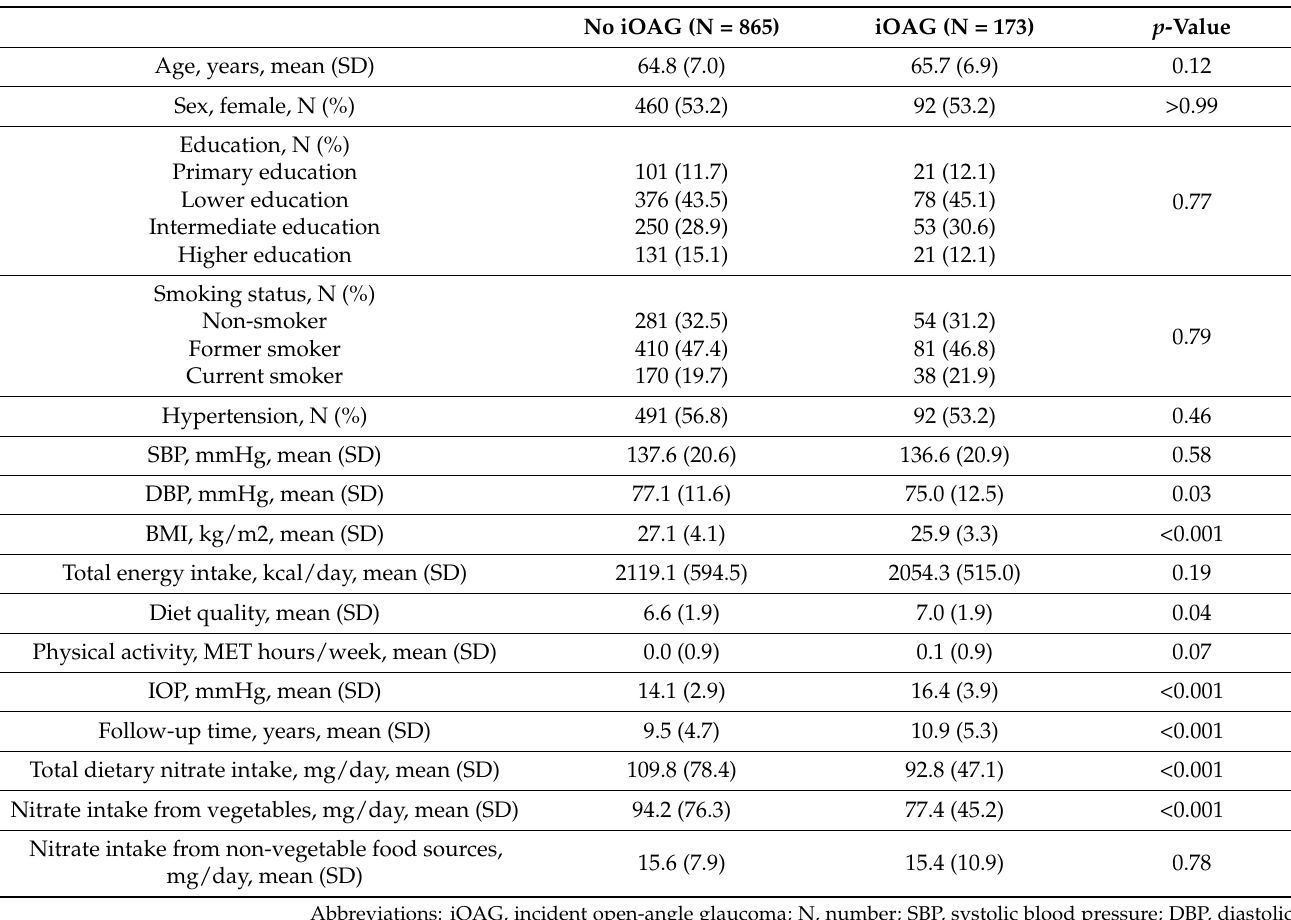
Table 1. Baseline characteristics of participants that did and did not develop incident open-angle glaucoma (iOAG) during follow-up.